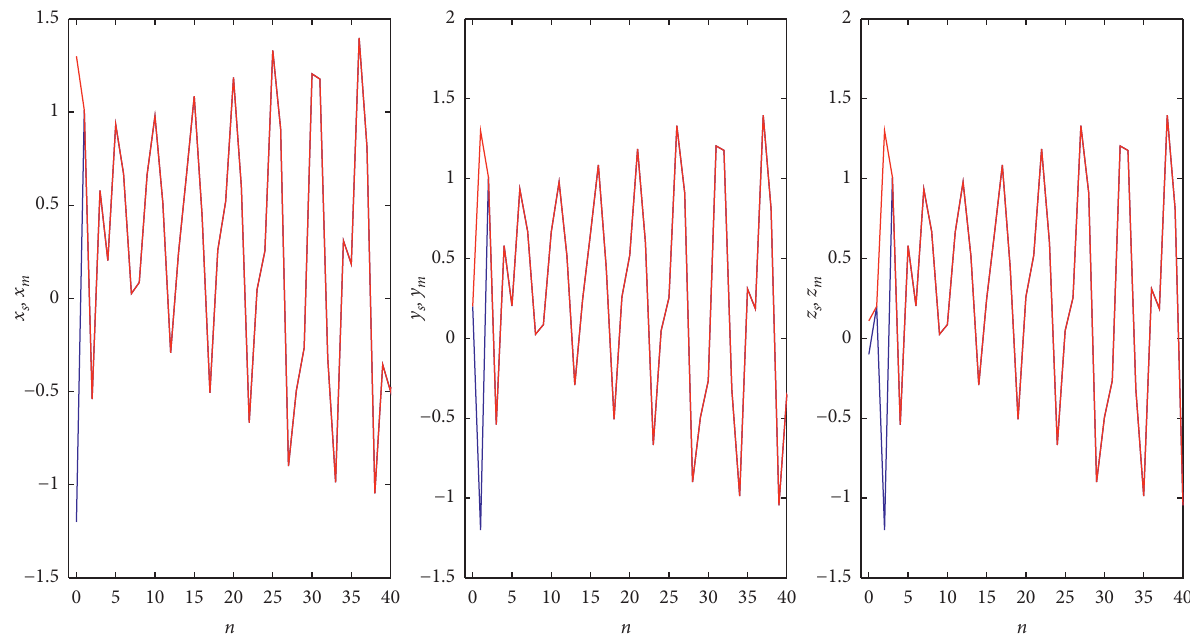
Figure 4: Synchronization of two identical Grassi–Miller map with α � 1, β � 0 . 5, and ] � 0 . 999: evolutions of the master system states (blue color) and of the slave system states (red